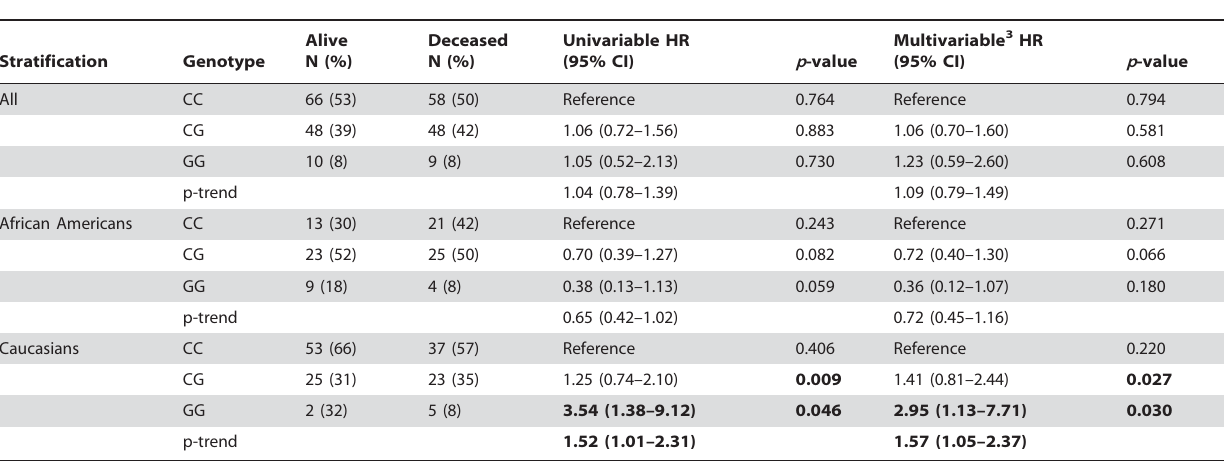
Table 3. Association of rs4919510 with colorectal cancer